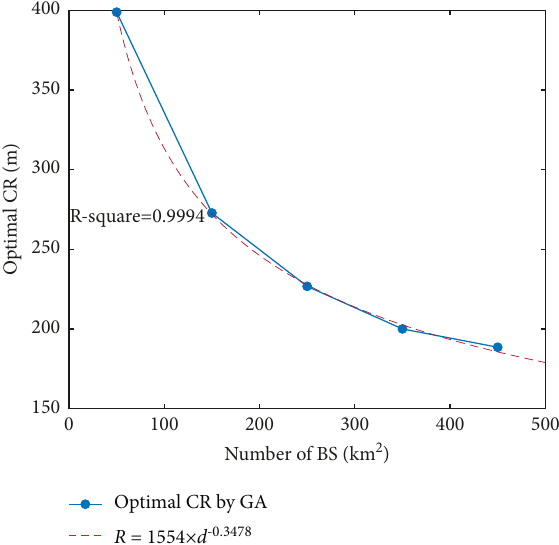
Figure 13: Optimal CRs under different BS